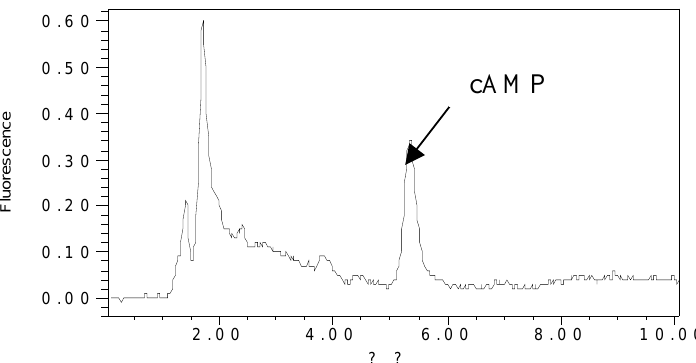
Figure 4. Chromatogram of cAMP (1fmol/ml) standard with HPLC-FL.